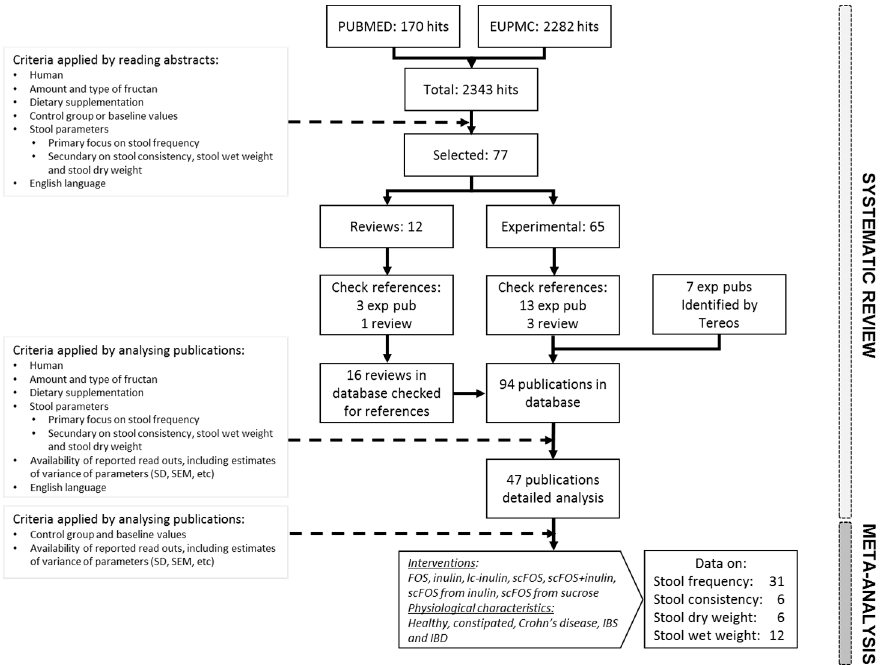
Figure 1. Flow diagram showing the results of the systematic literature search and meta-analysis on stool parameters.